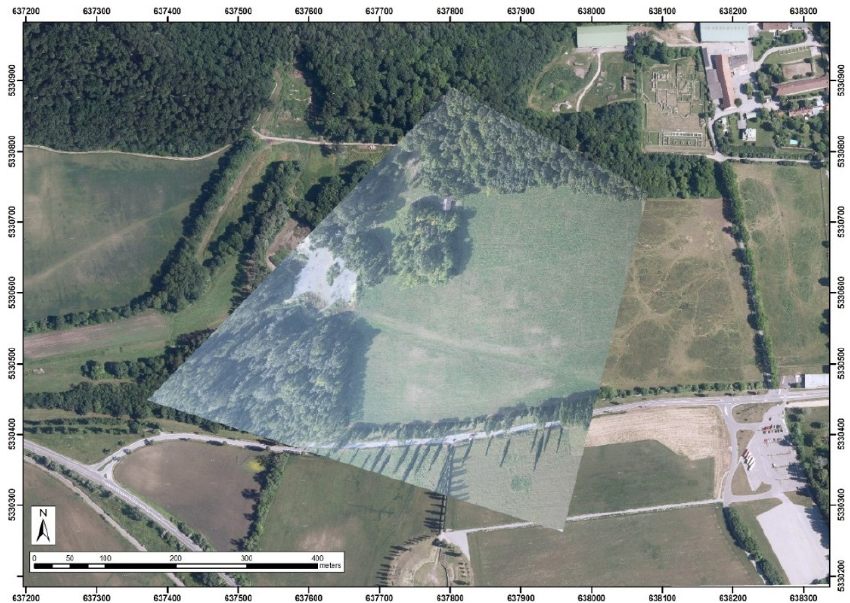
Figure 10. Carnuntum, Lower Austria. Transformation of a low-oblique photograph (pitch = 33°) based on its calculated footprint. Background data source: basemap.at [17].